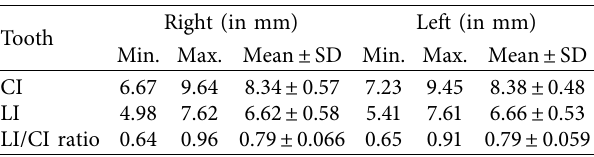
Table 4: Widths (measured between the proximal incisal contact area positions) of clinical crowns of upper incisors. Figure 1: Distribution of the study population according to sex.